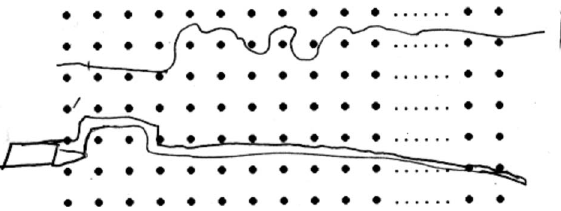
FIG. 1. A student’s drawing of sound “working its way through” by “finding little open areas” in between the